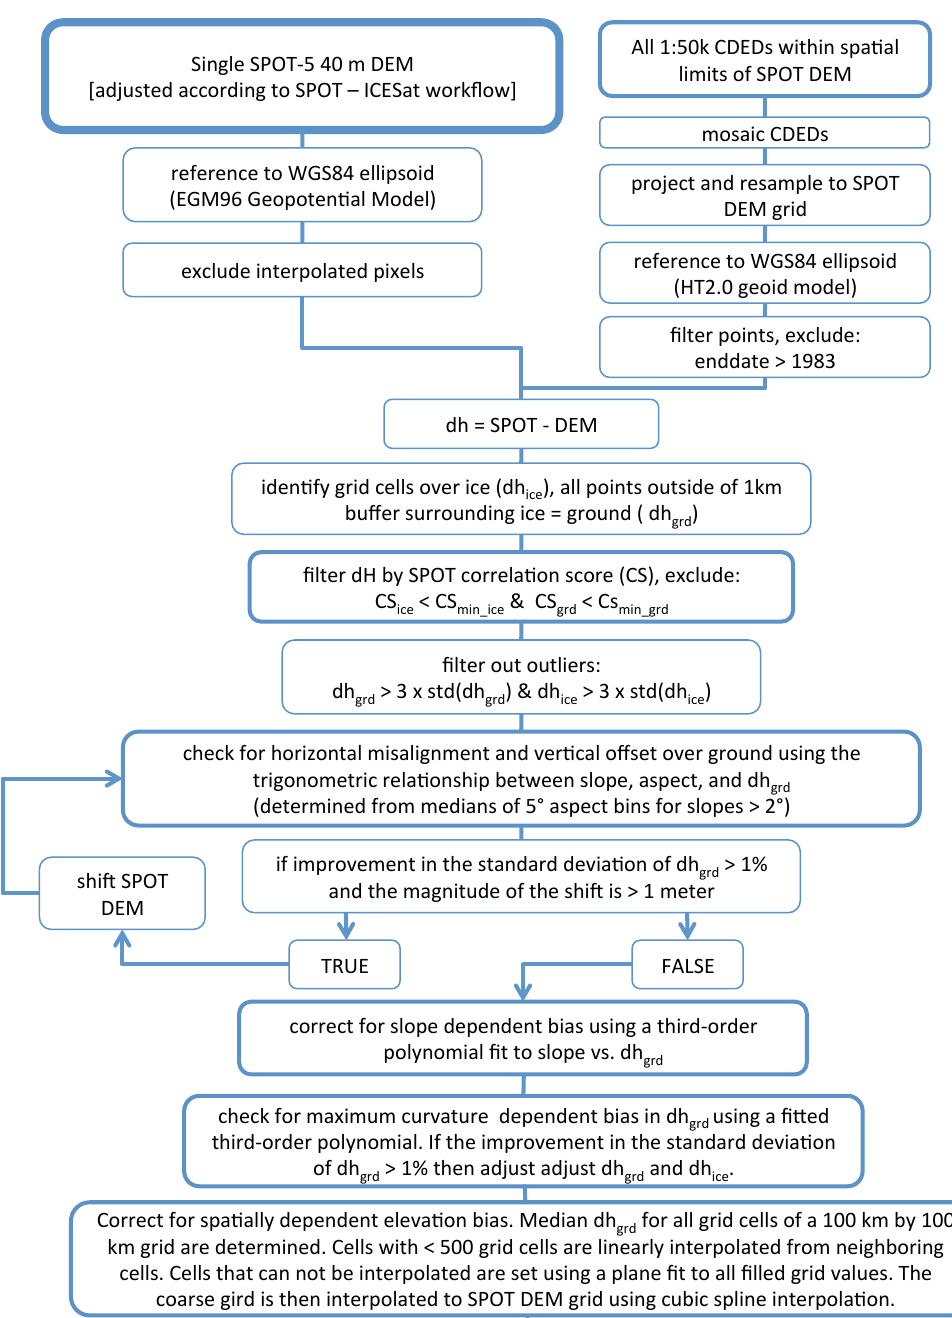
Fig. A2. Workflow for SPOT-CDED